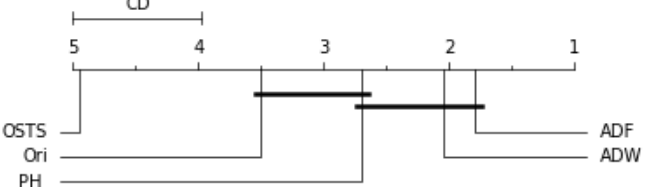
Figure 9. Comparison of the RMSE values obtained by segmentation techniques for TCN predictor according to the Nemenyi test. Groups that are not significantly different ( α = 0.05 and CD = 1.03) are